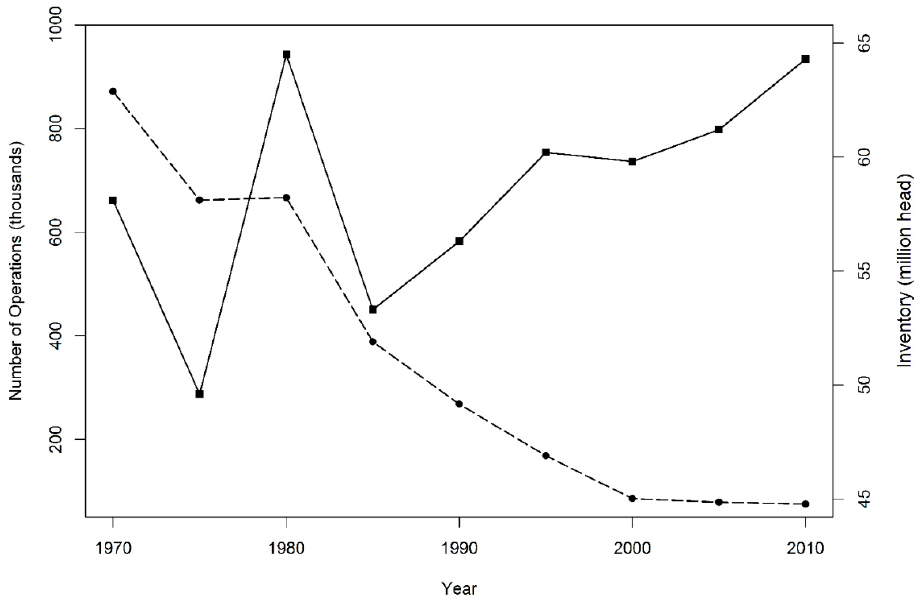
Figure 1. Number of swine operations in the U.S. over time (dashed line) versus the inventory of swine during that same time (solid line) [5].